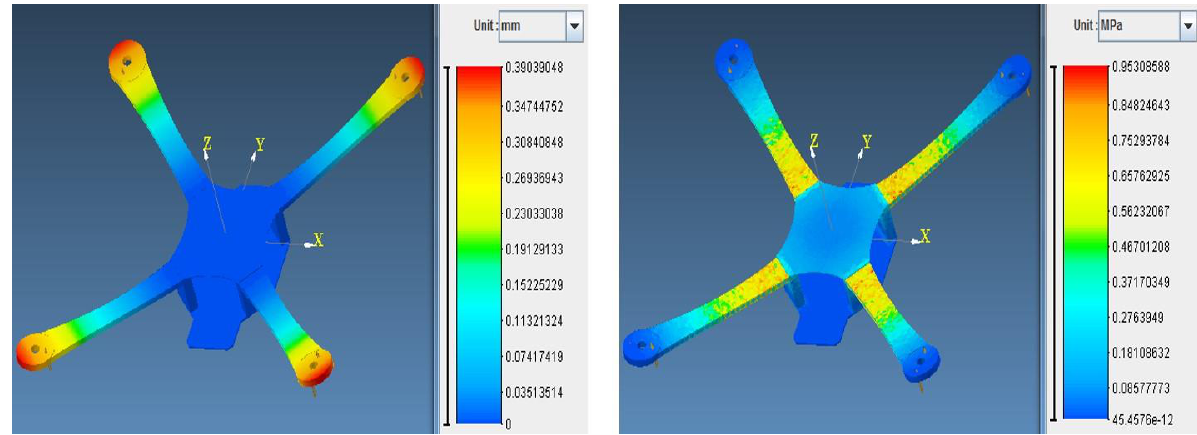
Figure 4. SAMCEF analysis for the deformation of the four arms ( left ) and the stress of the center ( right ).